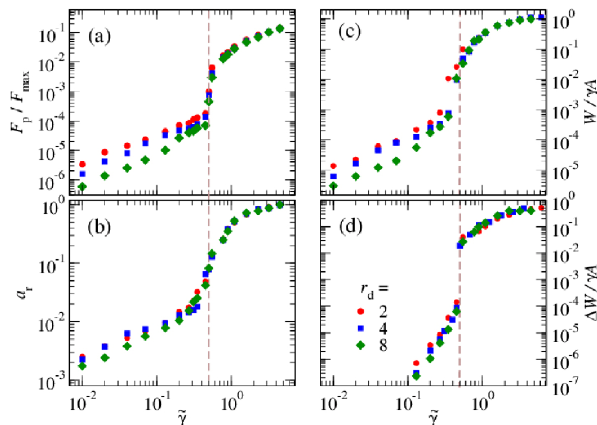
Fig. 5 Same quantities as in Fig. 4. This time, different ratios /   r λ are considered with fixed dd calculation is shown.